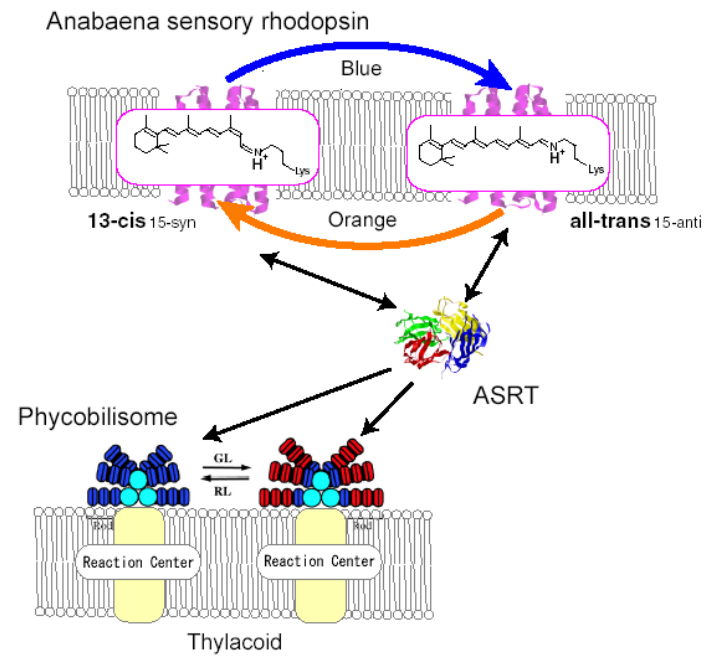
Figure 3. Proposed function of Anabaena sensory rhodopsin (1XIO[16]). ASR is interconverted into two isomeric states, which have different interactions with ASRT (2II9) [17]. ASRT maybe controls the expression level of phycobilisome proteins